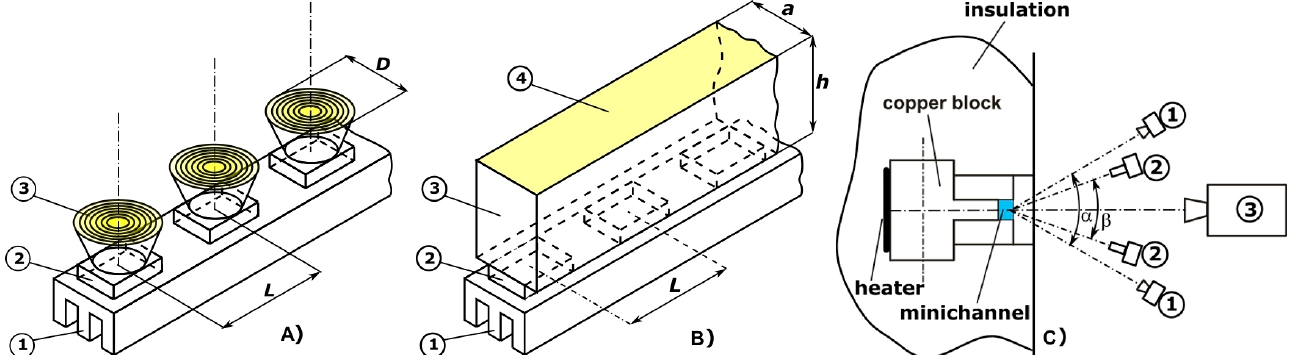
Figure 2. Components of LED lighting system (not to scale): ( A ) 1—radiator (aluminum alloy), 2—7xLED [Optoflash], 3—Fresnel lens [Citizen Electronics, Tokyo, Japan], dimensions: D = 28 mm, L = 30 mm; ( B ) 1—radiator (aluminum alloy), 2—4xLED [Citizen Electronics], 3—light transmitting plexiglass layer, 4—matt light-emitting surface, grinded with coarse grain, dimensions: a = 10 mm, h = 35 mm, L = 70 mm; ( C ) LED lighting system (not to scale), 1—type ( A ) illuminator, 2—type ( B ) illuminator, 3—high speed camera, α —angle of optic axes intersection for type ( A ) illuminators, β —angle of optic axes intersection for type ( B ) illuminators.